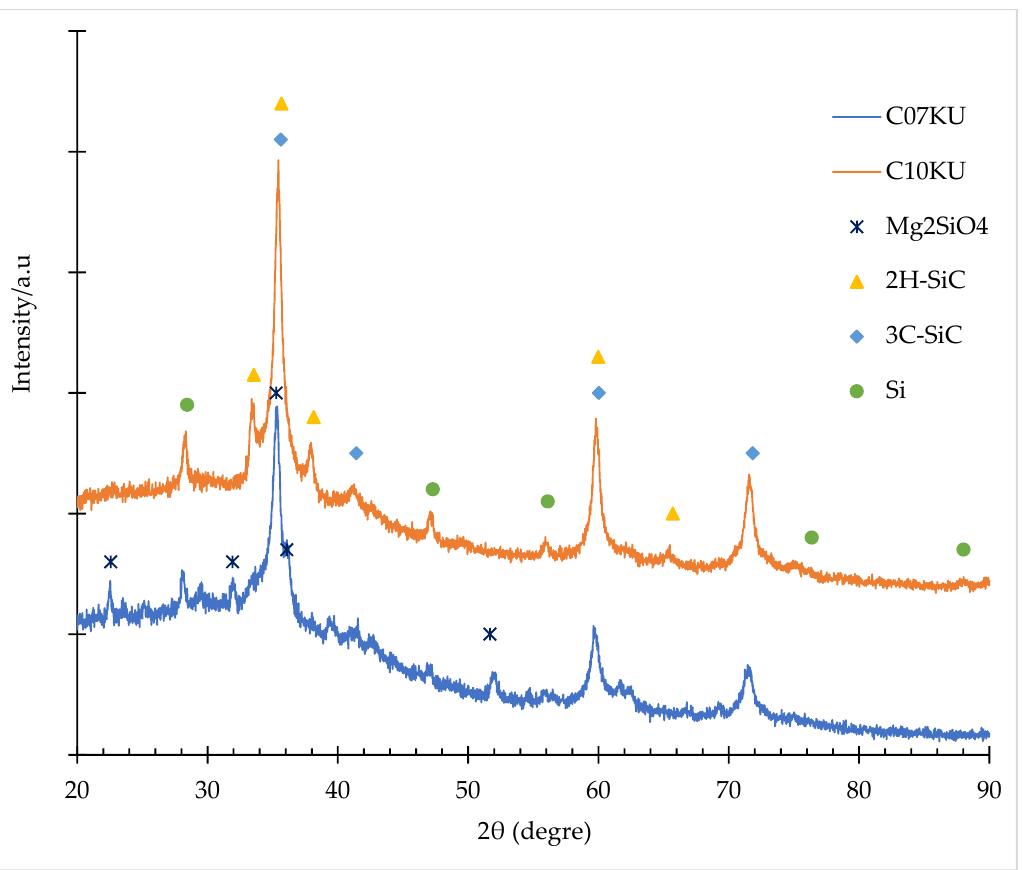
Figure 7. Diffraction pattern of calcined products in air atmosphere at 700 °C. Table 5. Comparison of compound composition of HCl washing product and air calcined product.